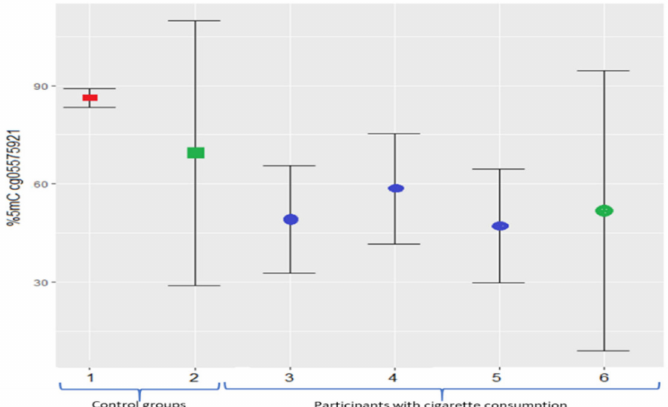
Figure 5. Mean methylation percentage (with standard deviation error bars) of cg05575921 ( AHRR ) site. The red square represents the non-smokers’ group; blue circles represent European American and African American smokers. The green square and circle represent the data obtained in this study. 1, non-smokers and white ethnicity [32]; 2, non-smokers in our study; 3, smokers with white ethnicity [32]; 4, African American smokers [52]; 5, European American smokers [52]; and 6, smokers included in this